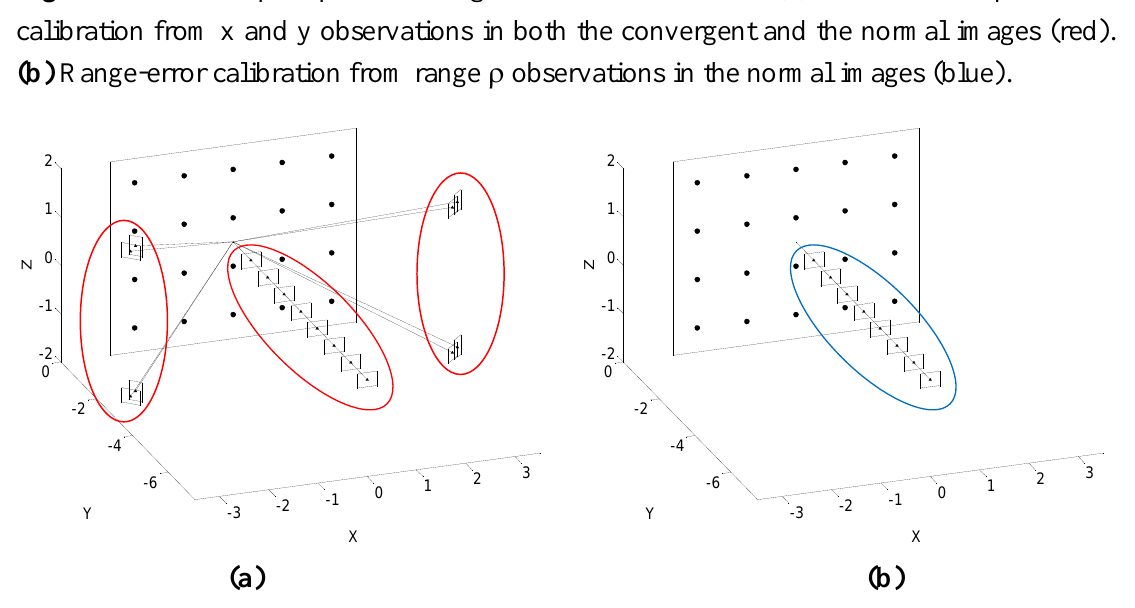
Figure 2. Two-step dependent range camera calibration. (a) Camera-lens parameter calibration from x and y observations in both the convergent and the normal images